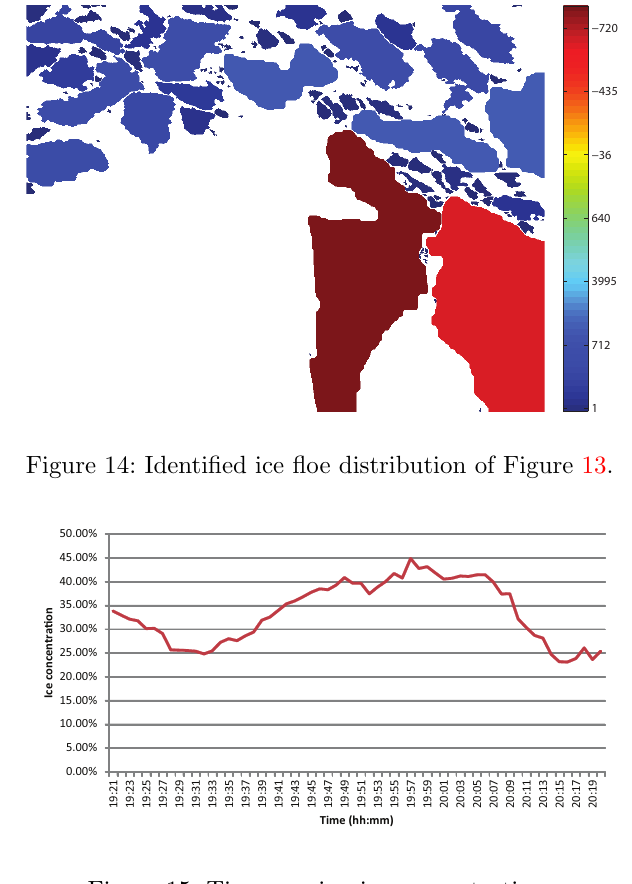
Figure 15: Time-varying ice concentration.